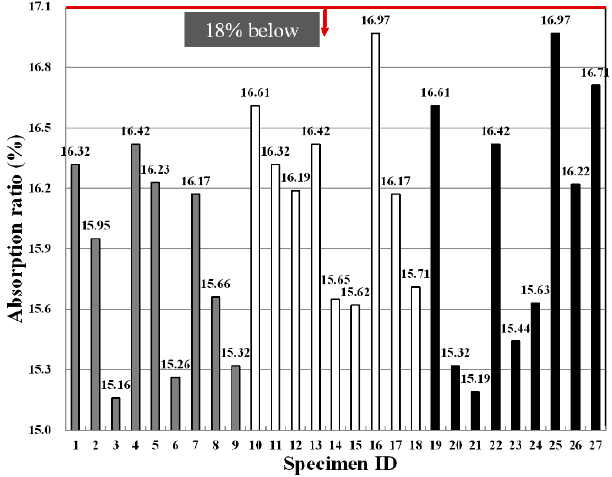
Figure 7. Variation of the absorption ratio for each specimen.